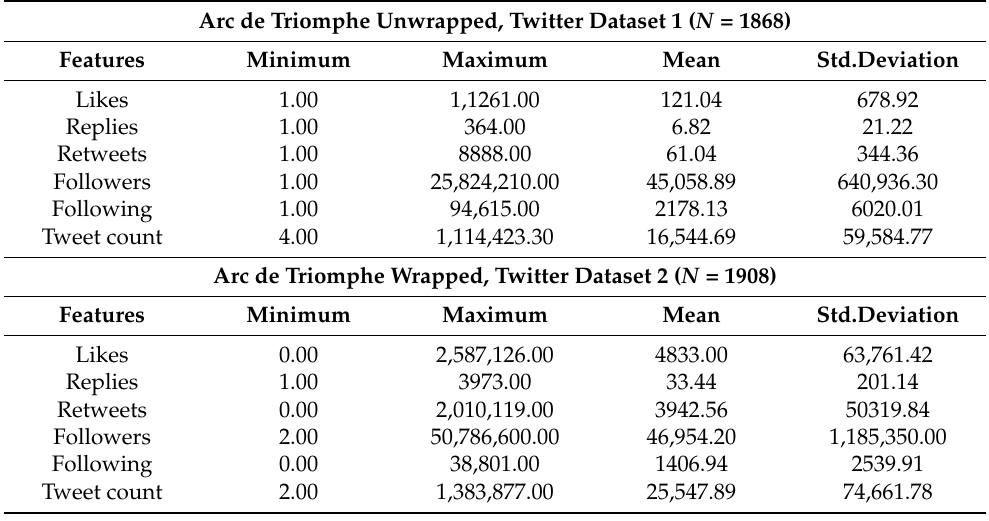
Table 3. The statistical description of the Arc de Triomphe Twitter